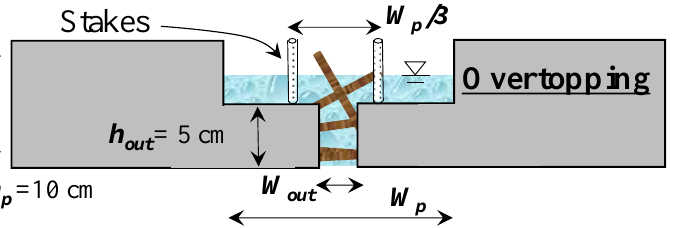
Figure 14. Wood debris trapping installation in the downstream opening of the sediment retarding basin as a countermeasure.